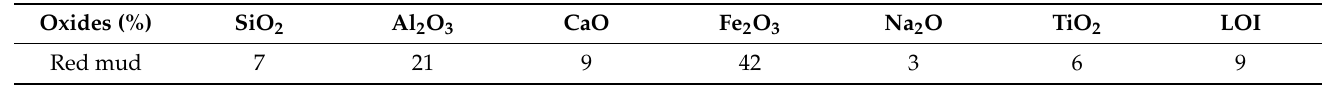
Table 12. Oxide composition of bauxite residue (Red mud).